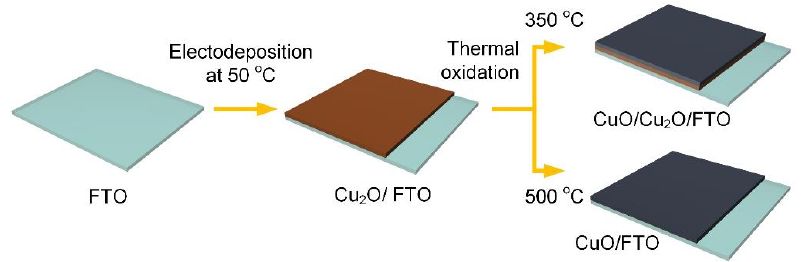
Figure 1. Schematic of the preparation process of copper oxide thin films on an FTO-coated glass substrate using electrodeposition and thermal oxidation at different temperatures.